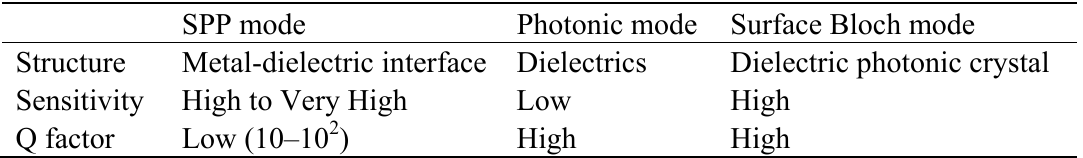
Table 1. Comparisons of optical modes: Photonic modes have oscillatory feature in the mode profile whereas an envelope function of surface Bloch mode exponentially